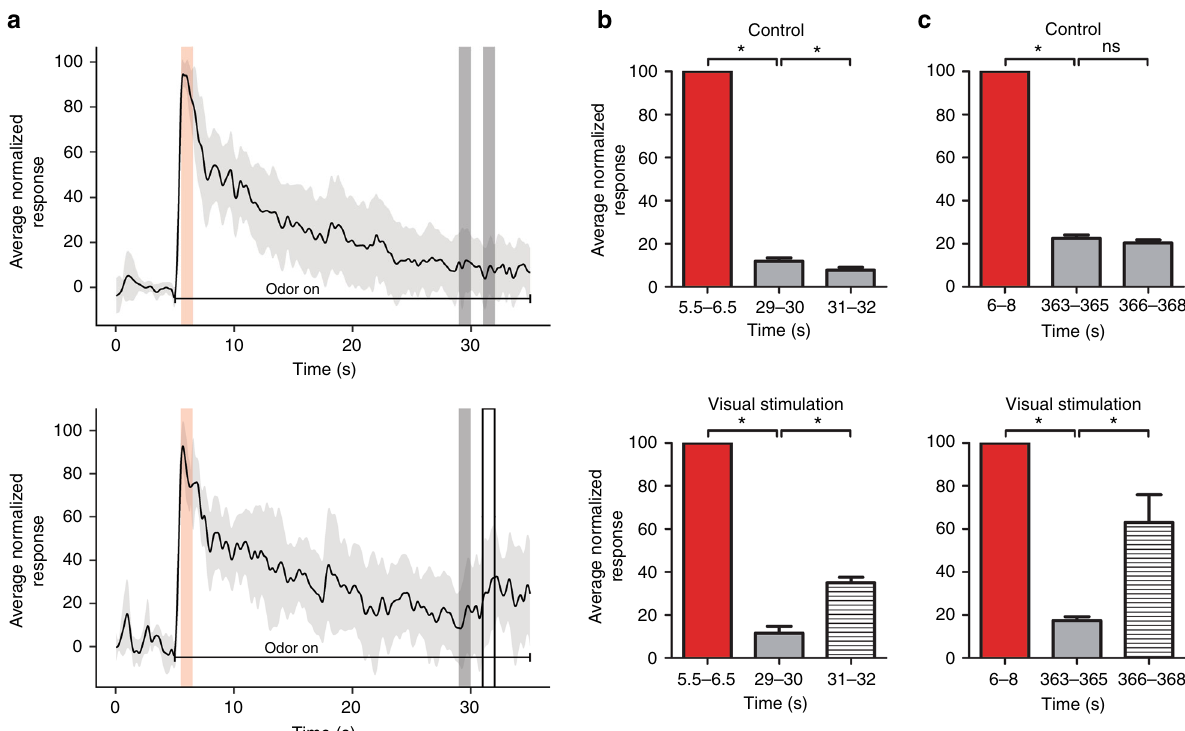
Fig. 6 A visual context change (VS) dishabituates glomerular odor responses following short and long odor presentations in awake mice. a Average fl uorescence trace (% of initial response ± s.e.m.) from all recorded glomeruli during control (top trace; n = 96 glomeruli, 4 mice) and VS conditions (white box, bottom trace; n = 73 glomeruli, 4 mice). b During 30 s trials, the average glomerular odor response (% of initial response ± s.e.m.) decreases during the odor presentation and signi fi cantly increases following VS. c During 7 min trials, the average glomerular odor response (% of initial response ± s.e.m.) decreases during the odor presentation ( n = 92 glomeruli, 4 mice) and signi fi cantly increases following VS ( n = 86 glomeruli, 4